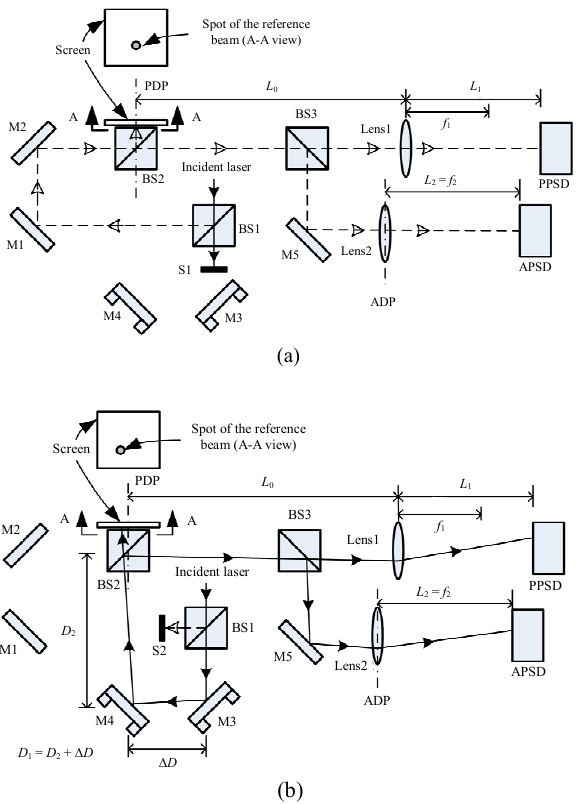
Fig. 2 Experimental optical layout: (a) the reference beam path and (b) the regulating beam